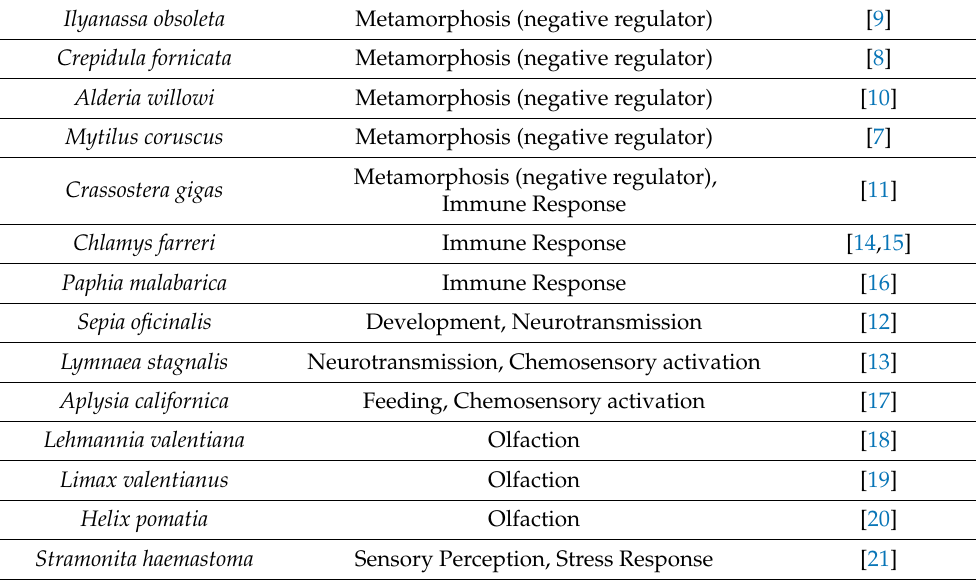
Table 1. Nitric Oxide signalling in molluscs. Survey of Nitric Oxide Synthases and NO signalling studied in molluscs, biological function and reference